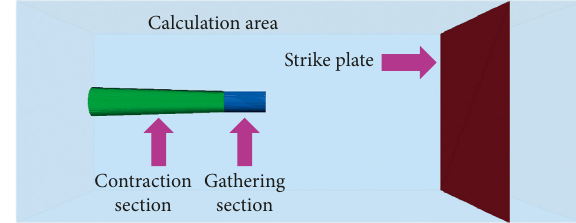
Figure 8: Geometric model